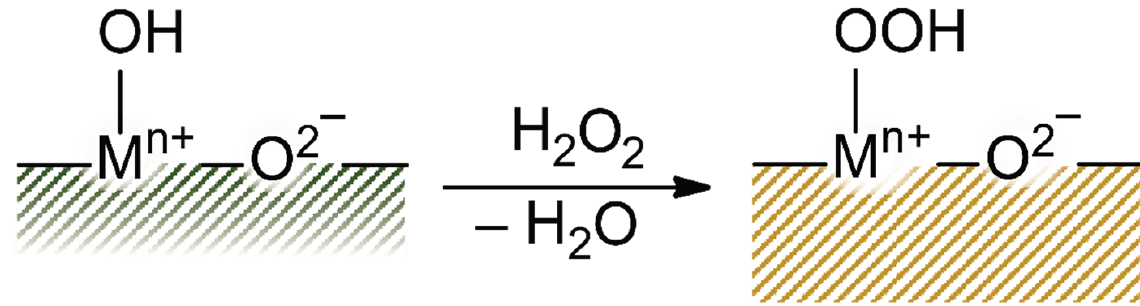
Scheme 2. Schematic representation of the activation of H 2 O 2 on metal oxides such as TiO 2 , adsorbed H 2 O molecules are omitted for